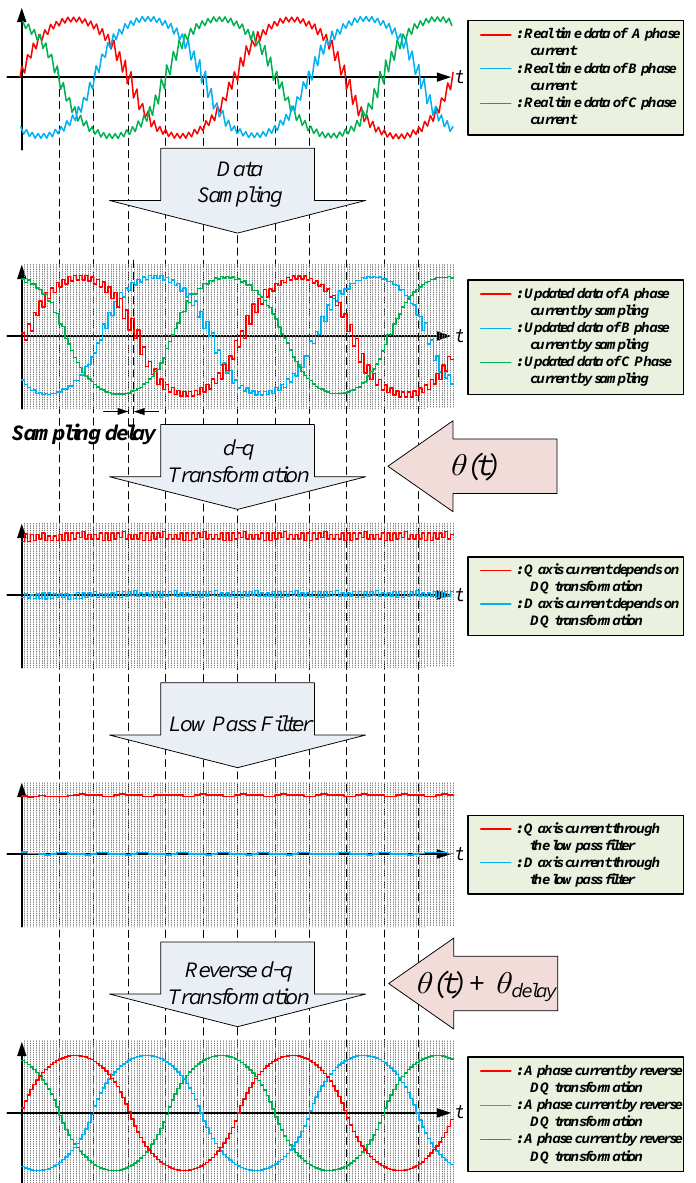
Figure 13. Flowchart of the compensating of the delayed phase angle of the phase current.